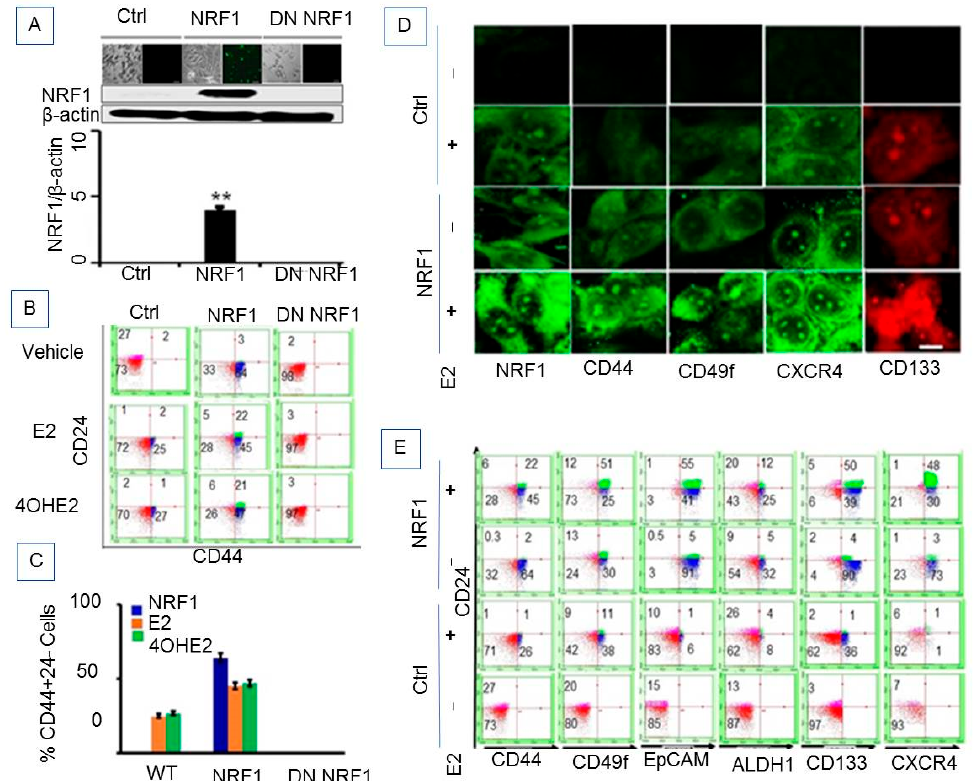
Figure 1. Heterogeneric subpopulations of estrogen-induced tumor initiating breast cancer-like cells. ( A ) Confirmation of NRF1 overexpression in MCF-10A cells after 14 days of transfection of cMV-NRF1-GFP construct (RG220113, OriGene Technologies, Rockville, MD, USA) detected by GFP expression by Nikon confocal microscopy (upper panel) and confirmed by Western blotting probing with anti-NRF1 antibodies (middle panel) and their subsequent densitometry analysis of NRF1 in relation to β -actin (bottom panel). Cell seeding was captured by phase contrast imaging (upper panel). ** p < 0.01 vs. control. ( B ) The representative flow cytometry data analysis showing effects of E2 and 4-OHE2 treatment to MCF10A cells on the expression of breast cancer stem cell markers CD24 and CD44. ( C ) The line graph represents the relative CD24 and CD44 co-expression in E2- and 4-OHE2- treated cells compared to vehicle control cells from three independent experiments. ( D ) Immunofluorescent detection of tumor initiating stem cell markers (NRF1, CD44, CD49f, CXCR4, and CD133) in E2-treated MCF10 A cells (Scale = 70 μ m, 650X). ( E ) The representative flow cytometry showing further sorting of the CD24 − /(low)/CD44+ cell population for expression of other BCSC markers—ALDH1A1, CXCR4, NRF1, and CD133.